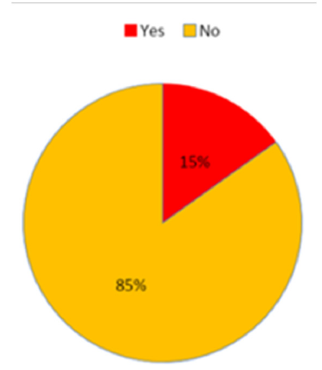
Figure 5. Reply to the question, “Do you think that generating electricity from solar panels on the roof of your house is a danger to your